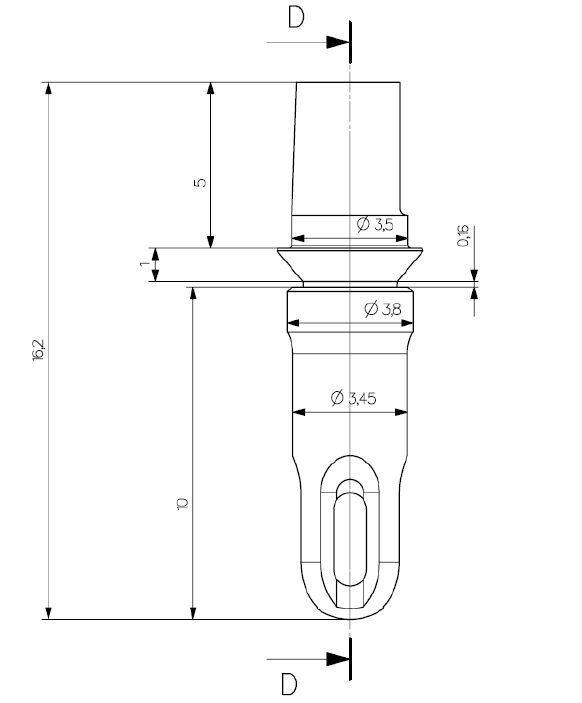
Figure 3. Documentation of the new internal (IH) connection variant of the implant.The intraosseous part is the subject of a patent